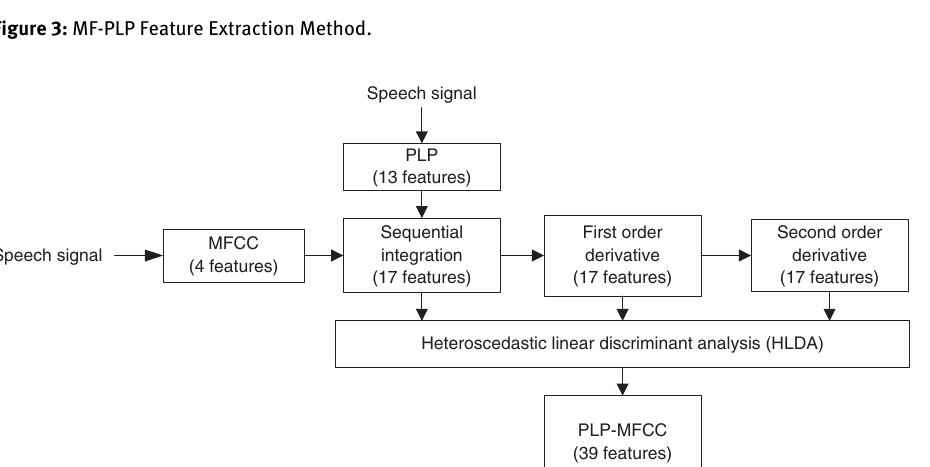
Figure 3: MF-PLP Feature Extraction Method.